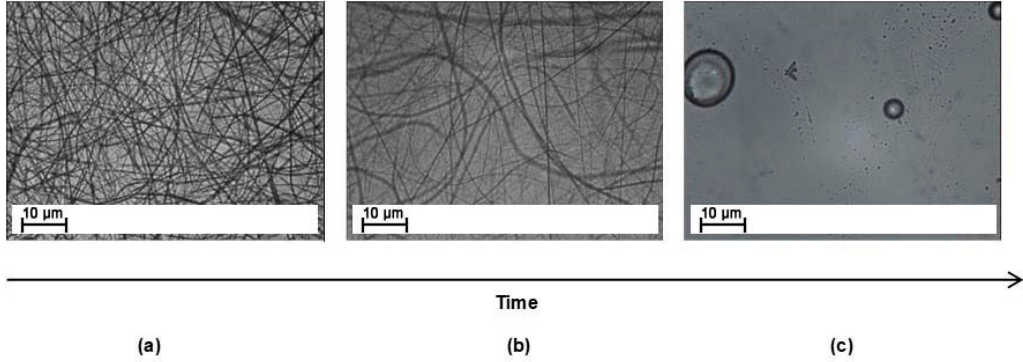
Figure 1. Hot-stage microscope screenshots for systems modified with coPES 9k treated at 100 °C at different times: ( a ) t = 0; ( b ) half dissolution; and ( c ) complete dissolution.